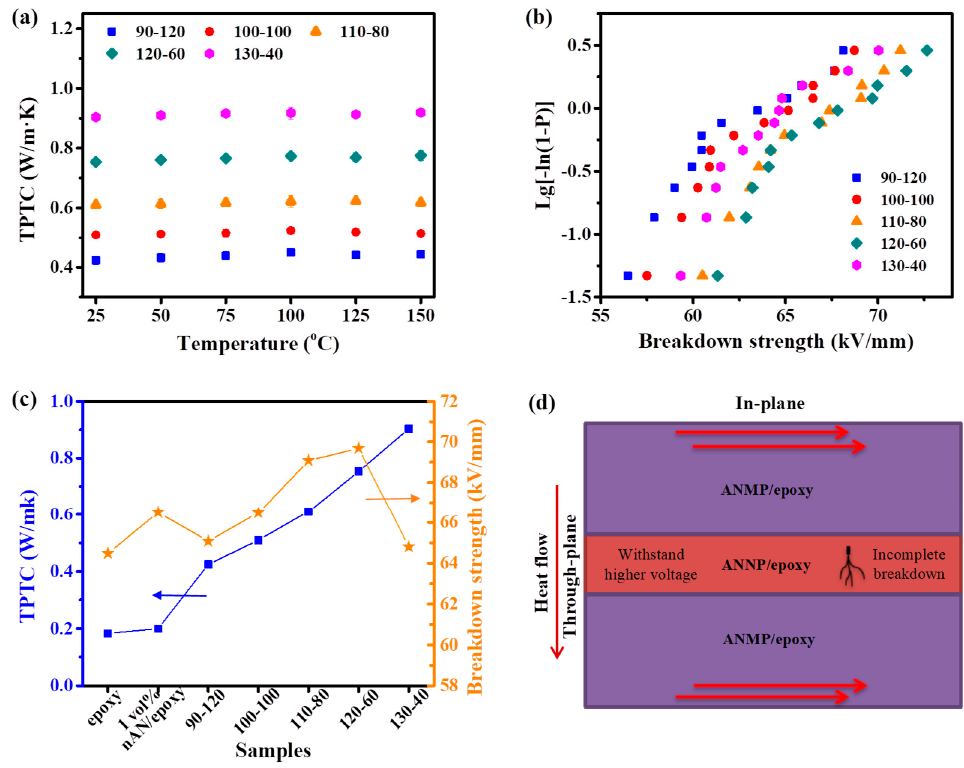
Figure 3. ( a ) TPTC of sandwich composites at different temperatures, ( b ) Weibull distribution for breakdown strength of sandwich composites, ( c ) comprehensive contrast of thermal conductivity and dielectric breakdown strength, ( d ) sche- matic of thermal transport and breakdown in sandwich composite.